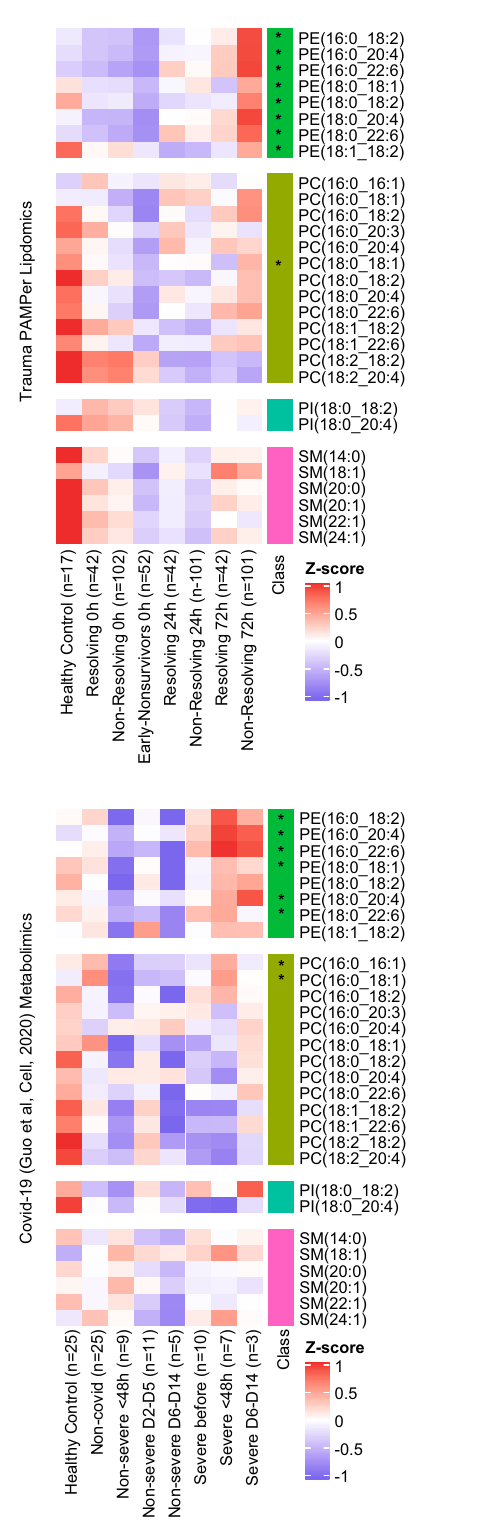
Fig. 4 | Comparison of temporal patterns of common lipids for patients with trauma or COVID-19. a , d Heatmaps show the relative levels of 29 common lipid species from four major classes across patients. Data comes from trauma patients fromthePAMPerlipidomicsdataset( a )andTD-2untargetedmetabolomicsdataset ( b ); COVID-19 patients from untargeted metabolomics dataset (Guo et al. Cell, 2020) ( c ) and lipidomics dataset (Shui et al., Cell metabolism, 2020) ( d ). Patients are groupedby outcome and sampling timepoint (except for d ).Asterisks indicate